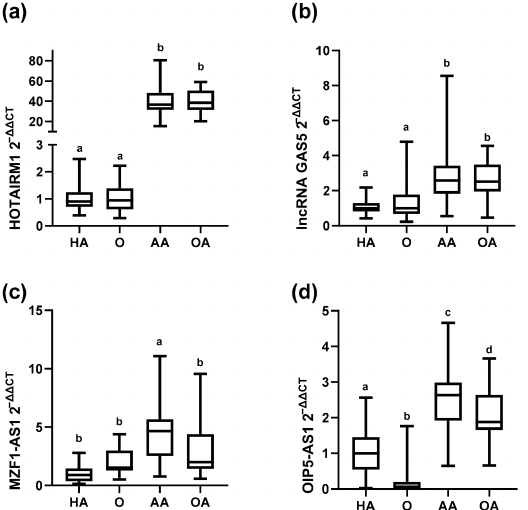
Figure 1. Differential expression of long noncoding RNAs: HOTAIRM1, GAS5, MZF1-AS1, and OIP5-AS1 from the four studied groups’ whole blood. ( a ) HOTAIRM1 expression levels comparison between studied groups. ( b ) lncRNA GAS5 expression levels comparison between studied